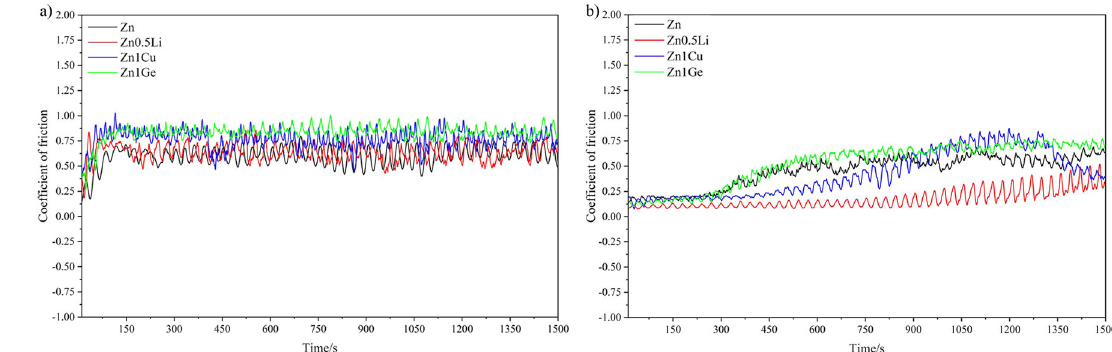
Fig. 2 Coef fi cient of friction vs sliding time of four metals: ( a ) under dry sliding condition; ( b ) in simulated body fl uids (Hank ’ s solution).